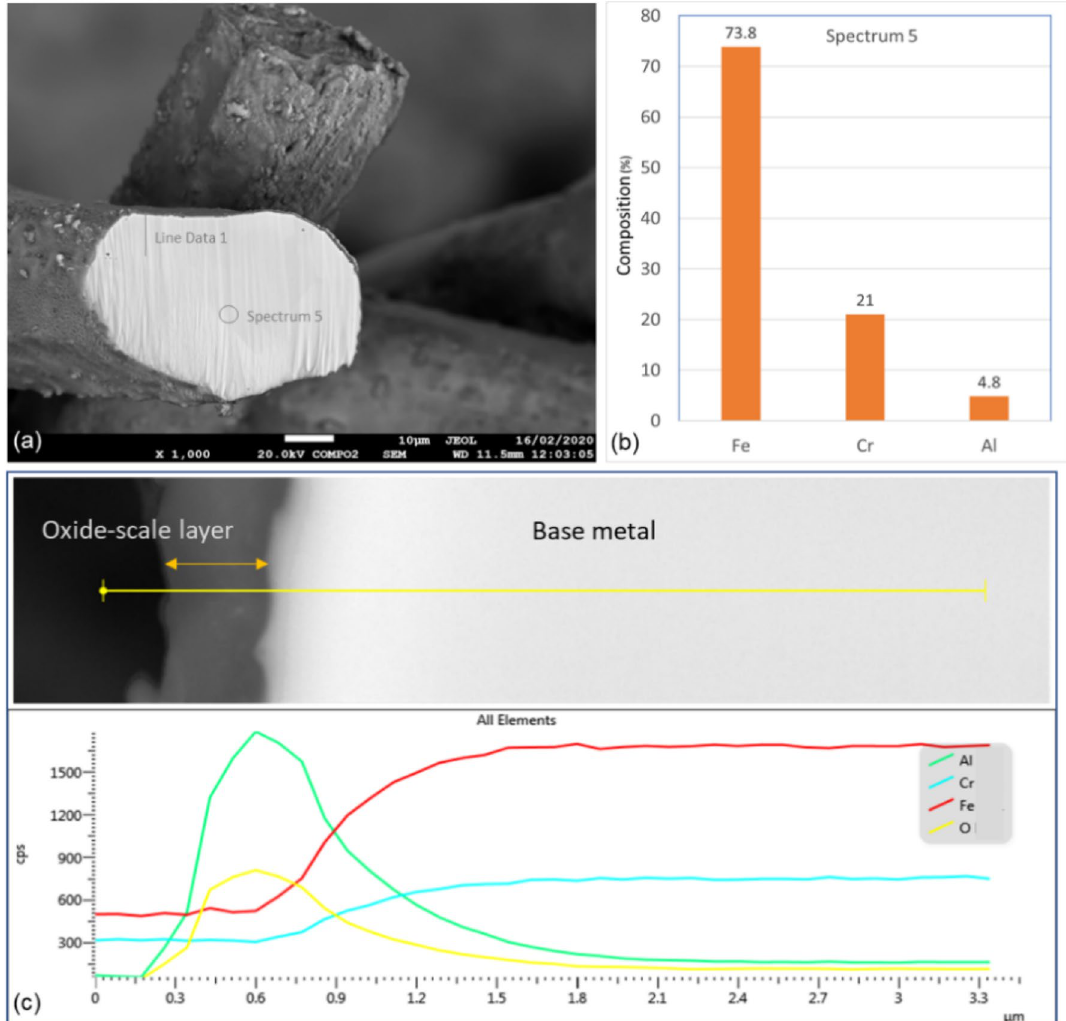
Figure 8. ( a ) Cross-section of Sample 2, 40 µm fiber; ( b ) EDS scans of Spectrum 5; ( c ) The characteristic x-ray counts along the specified line scan (Line Data 1) marked in Fig.